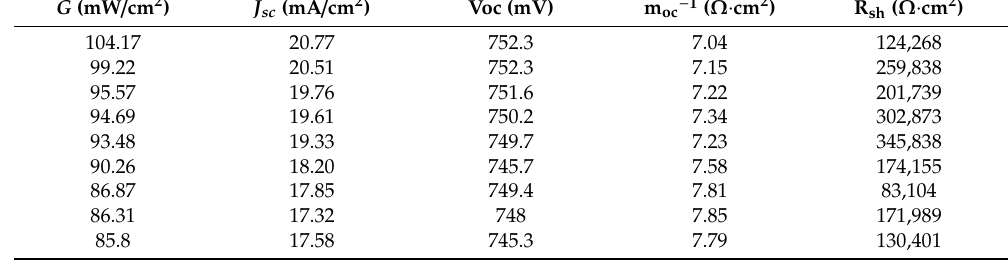
Figure 2. V oc versus ln( J SC － V OC / R sh ) for extraction of n and J 0 for cell #1. The Inset is an expanded view for the dotted part.